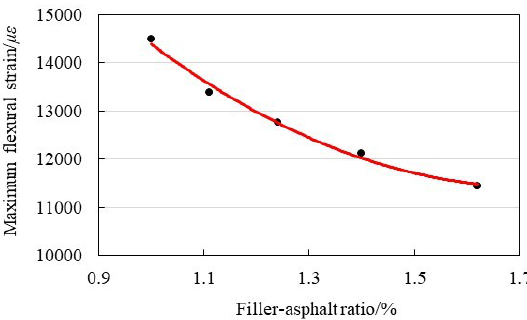
Figure 10. Relationship between maximum flexural strain and filler-asphalt ratio of SMA-II-3 mixture beam at − 10 ◦ C, loading rate of 50 mm /